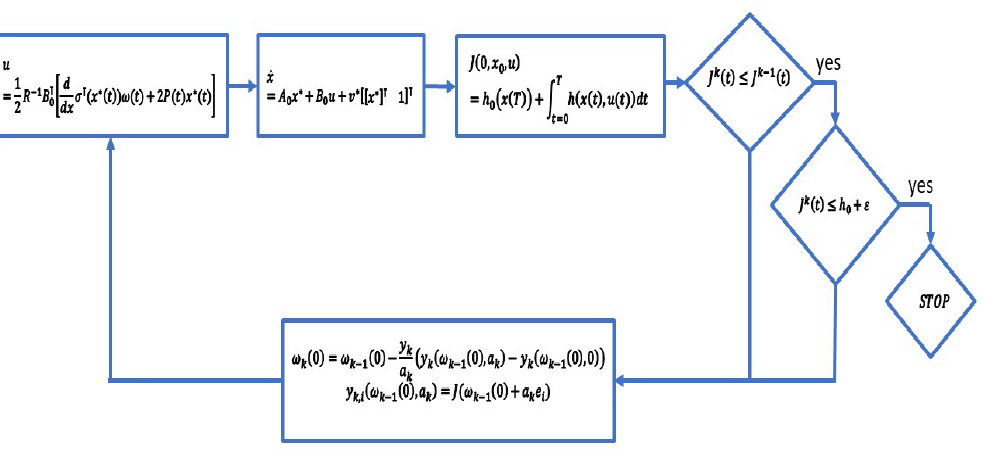
Figure 1. Diagram of the min–max optimization approach based on the hybrid form based on the DNN approximation of the Bellman’s function to derive the controller and the recurrent method to force the fulfilment of the final